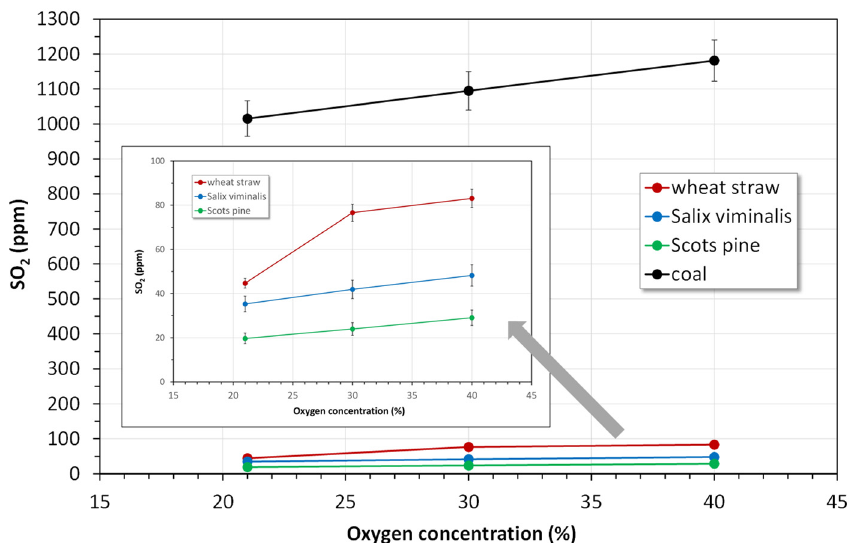
Figure 16. Influence of the oxygen concentration on total emissions of SO 2 during oxy-combustion. Vertical bars represent standard deviation.